Question: Reading the figure, is the described quantity rising or falling?
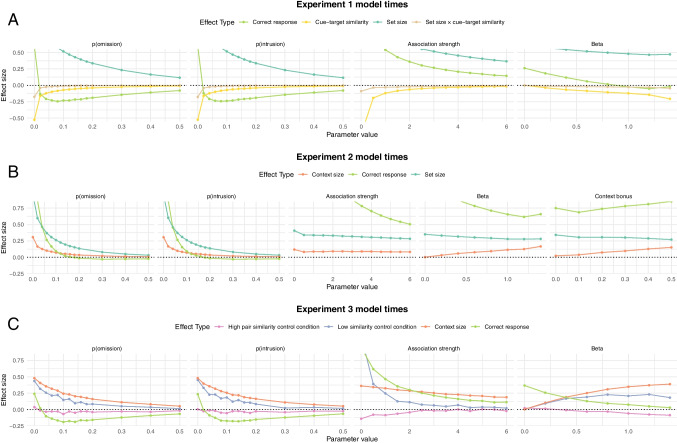
Answer: increasing